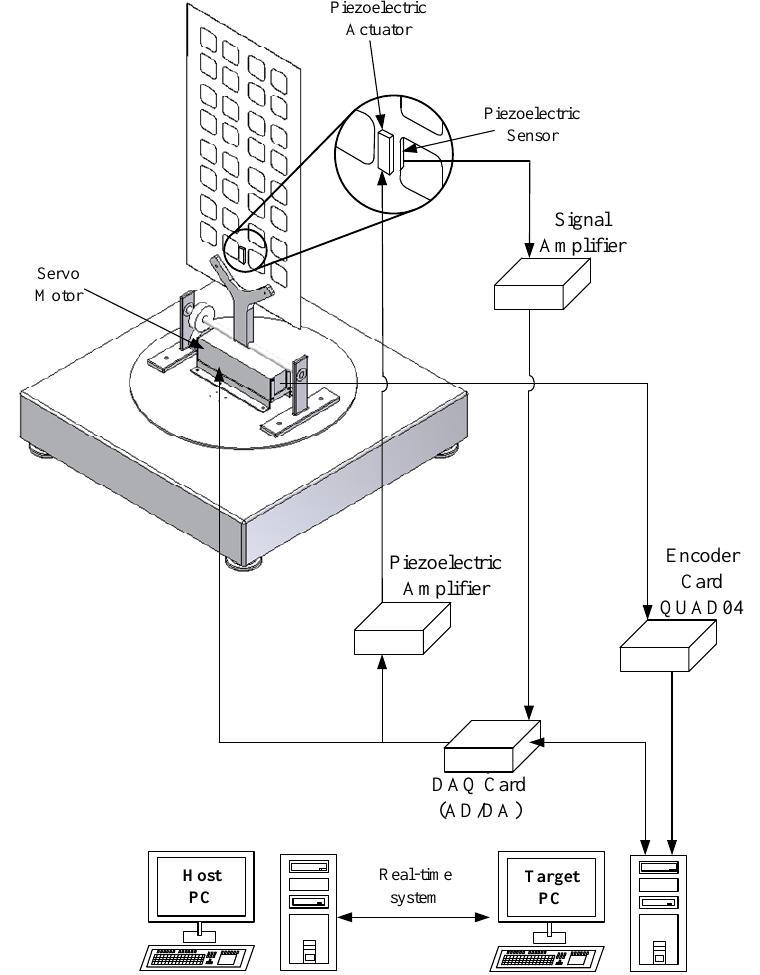
Figure 6. Schematic diagram showing vibration control system for large flexible structures. Table 1. Properties of the flexible plate.